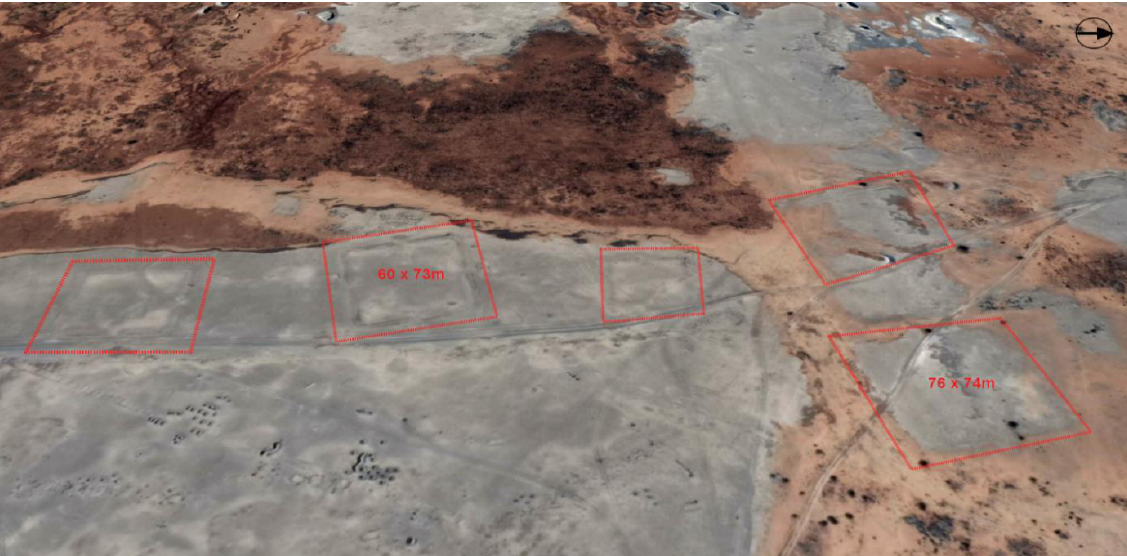
Figure 8: Remains of five auxiliary forts near the main fortress from the East. These were partly equipped with clearly visible titulum barriers positioned before the entrances. Oblique view from the